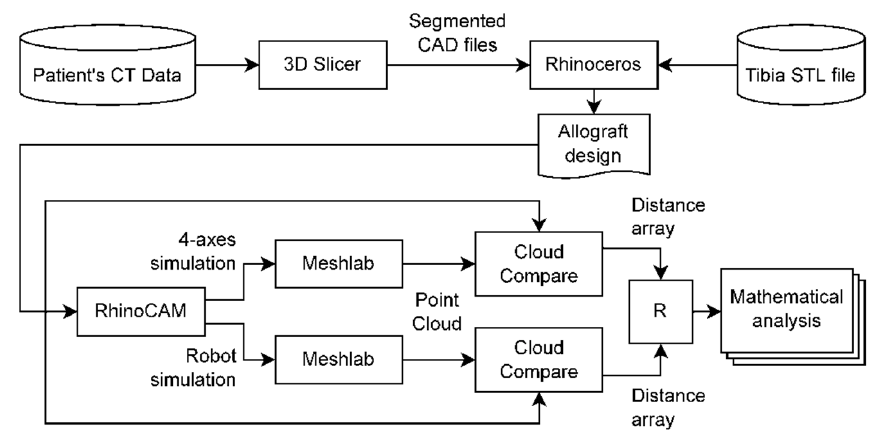
Figure 1. Flowchart of the data and software used in the simulation protocols. (CT: computer raphy; CAD: computer aided design; STL: stereolithography; CAM: computer aided tomography; CAD: computer aided design; STL: stereolithography; CAM: computer aided manufacturing).